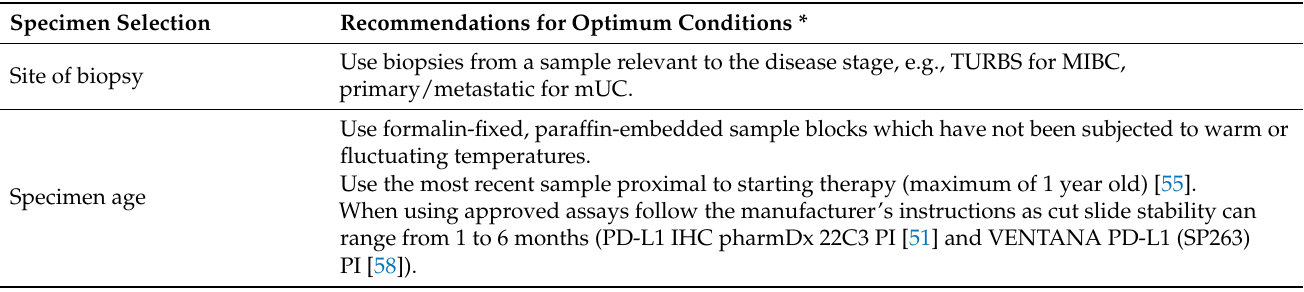
Table 2. Recommendations for optimal conditions for PD-L1